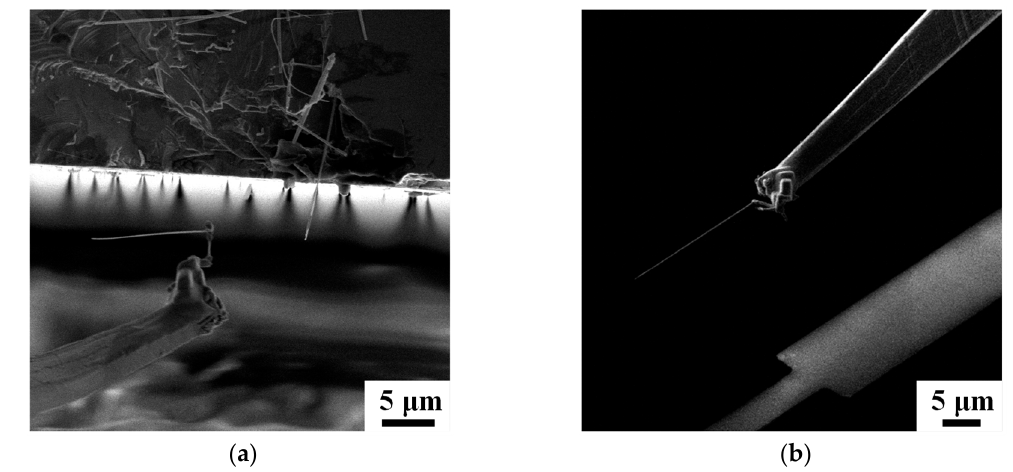
Figure A1. SEM images of a single silicon nanowire manipulation: ( a ) a single silicon nanowire was